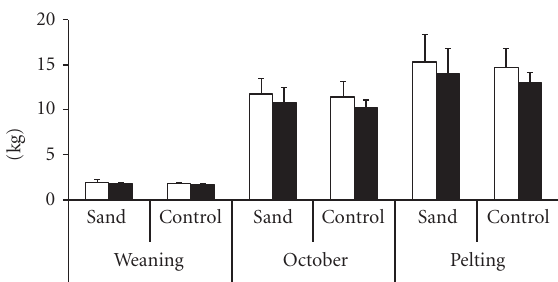
Figure 1: Body mass (kg, mean + SD) of juvenile blue foxes in the Sand and Control groups at the cubs’ age of eight weeks (weaning), in early October and at pelting (mid-December). Open bars: males, solid bars: females. Main e ff ects (GLM for repeated measures): Group F (1,14) = 0 . 64, NS; Sex F (1,14) = 9 . 78, P = . 007; Month F (2,21) = 489 . 54, P = . 000; Sex ∗ Month F (1,18) = 7 . 50, P = . 009, other interactions